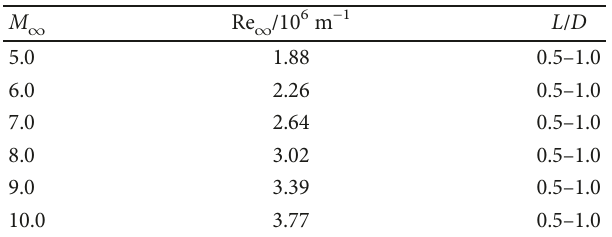
Table 1: Incoming fl ow condition and con fi guration of the spiked